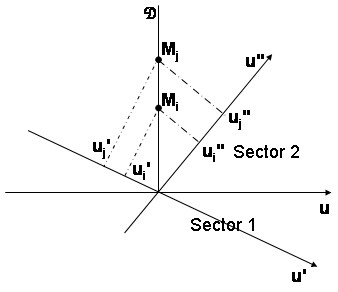
Passage through the critical direction u, from sector 1 to sector 2. - u is a direction perpendicular to the splitting direction ; Mi and Mj are two point locations in the geographical space; - Change in the order of the projected coordinates on the u' and u" directions; - u' and u" are directions with intermediate angles, belonging respectively to sector 1 and sector 2; - u'i, u'j, u"i, and u"j are the projected coordinates of points Mi and Mj: u'i > u'j and u"i <u"j.